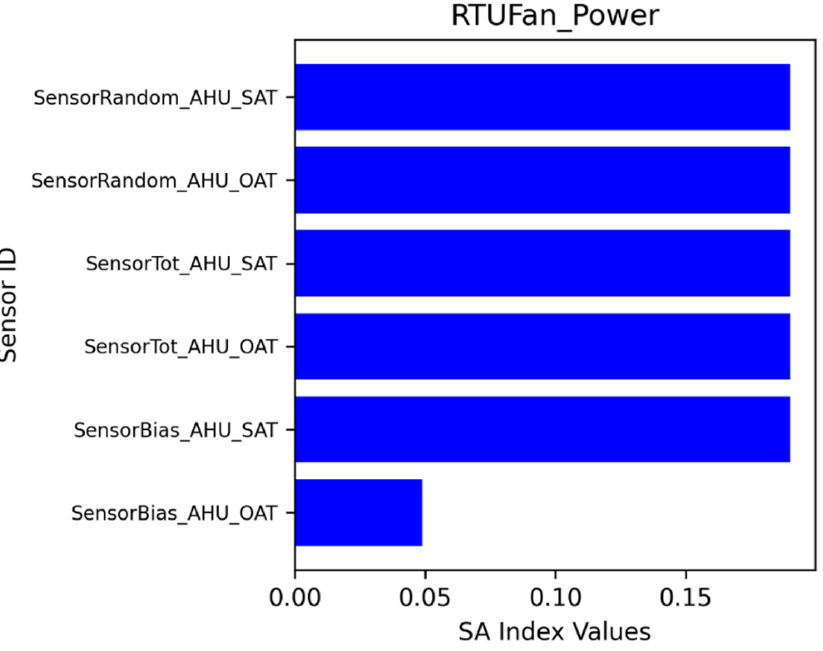
Figure 18. SA for RTU fan power.